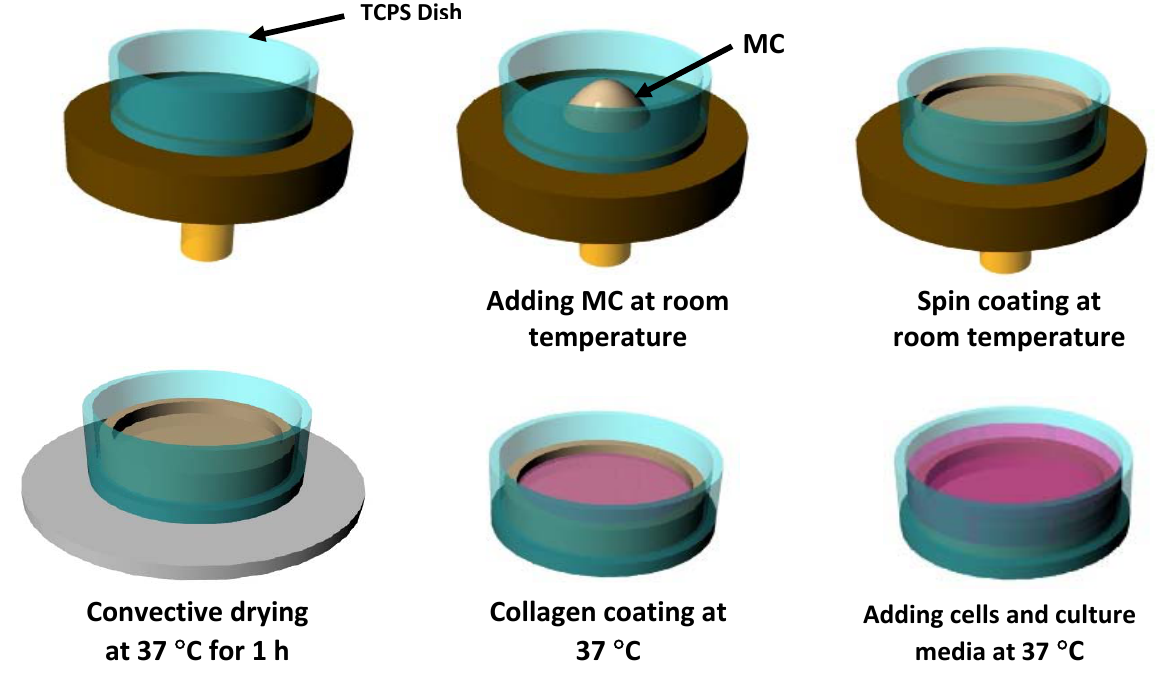
Figure 1. Schematic illustration of the preparation of methylcellulose (MC)-Collagen hydrogel system using spin coating procedure. Approximately 400 µL of the aqueous MC solution was poured into the center of each TCPS dish at room temperature. Spin coating was used as described in the Materials and Methods to evenly spread a thin transparent layer of MC on the TCPS dish. After a convective drying at 37 °C for one hour, a thin layer of collagen type 1 was evenly spread using a sterile cotton swab for improving cell adherence to MC hydrogel